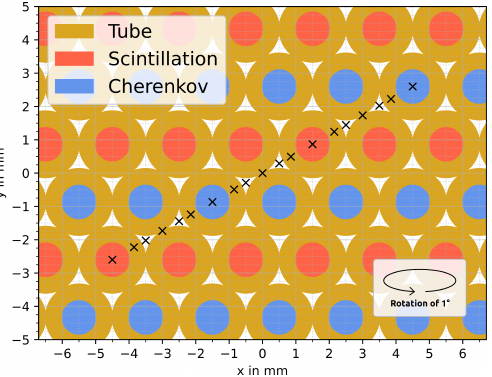
Figure 2. Simulated beam impact positions with a pencil-like beam of no radial extension. The beam travels in the (negative) z direction.